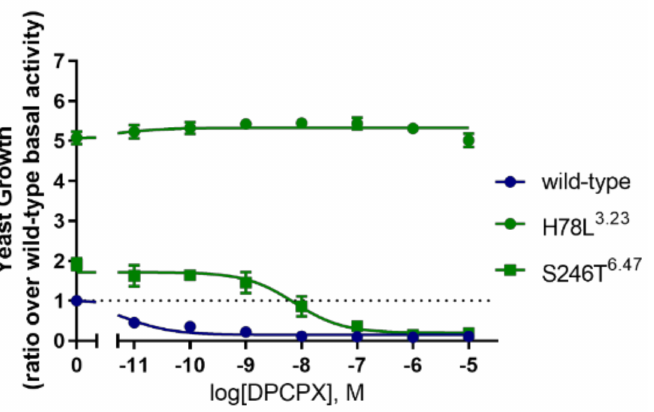
Figure 3. Concentration–inhibition curves of the hA 1 AR inverse agonist DPCPX at the wild type A 1 AR and the CAMs, H78L 3.23 , and S246T 6.47 . Data were normalized as ratio over basal activity of wild type hA 1 AR (dotted line). Combined graphs are shown as mean ± SEM from at least three individual experiments performed in duplicate. Data for wild type are shown in dark blue and for CAMs in